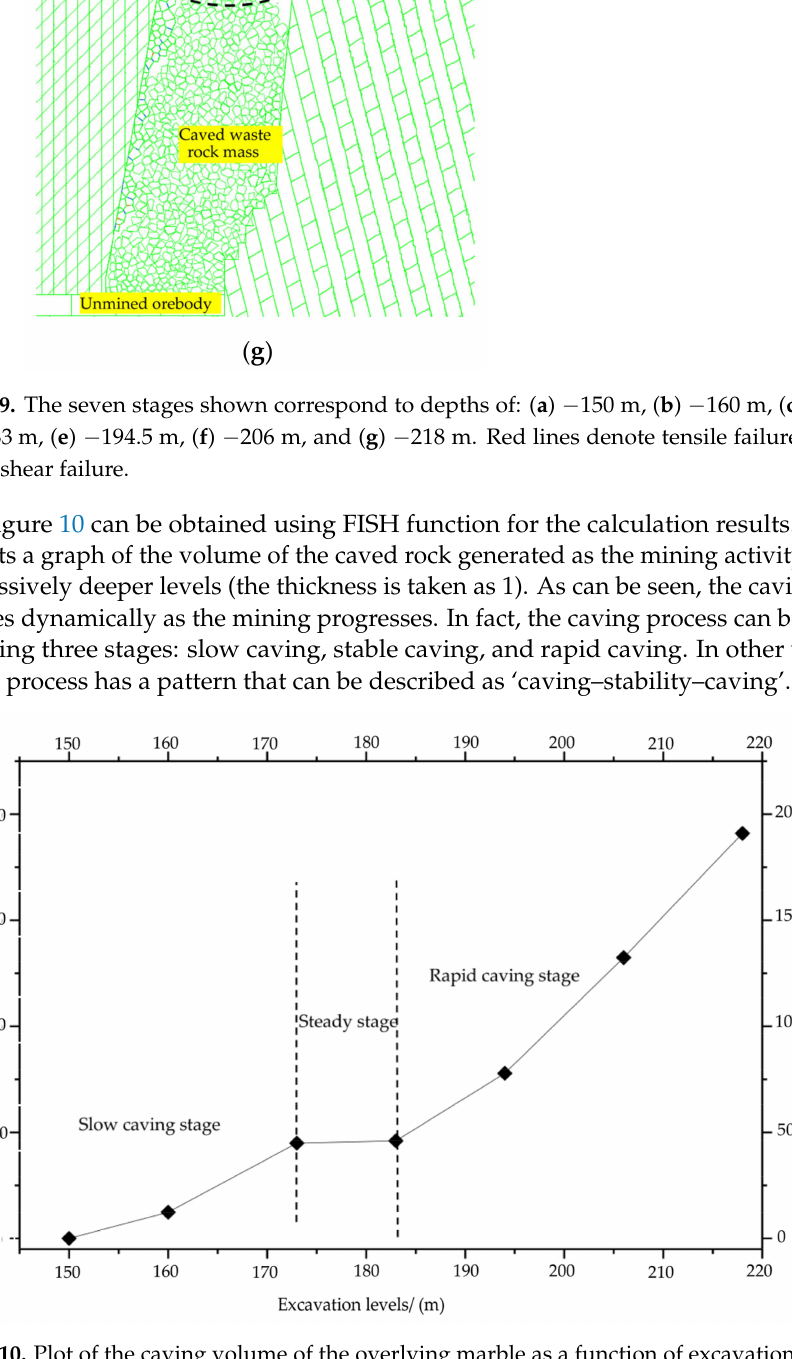
Figure 10. Plot of the caving volume of the overlying marble as a function of excavation